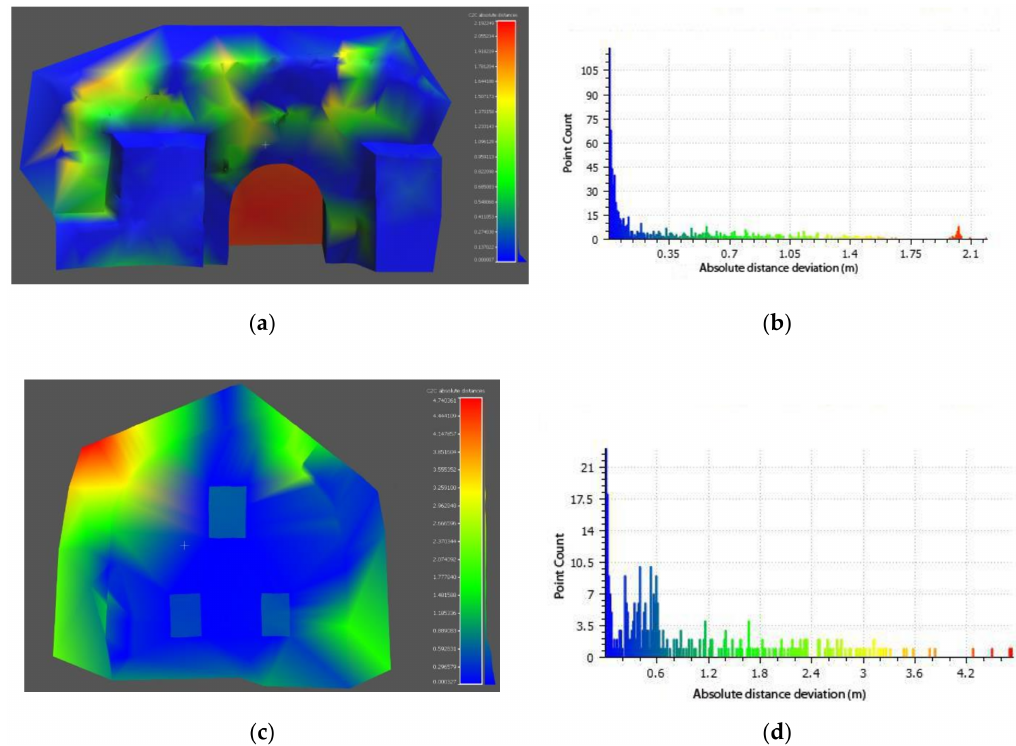
Figure 14. The comparison of the 3D model with the reference data: ( a ) the model of the west side part of Neoria with a color scalar field depicting the data deviation (blue < green < yellow < red); ( b ) the distribution of the aforementioned surface points according to their deviation from the reference data; ( c ) the corresponding color scalar depiction of the front side part of Neoria; and ( d ) the matching histogram of the relation of surface data and their deviation.